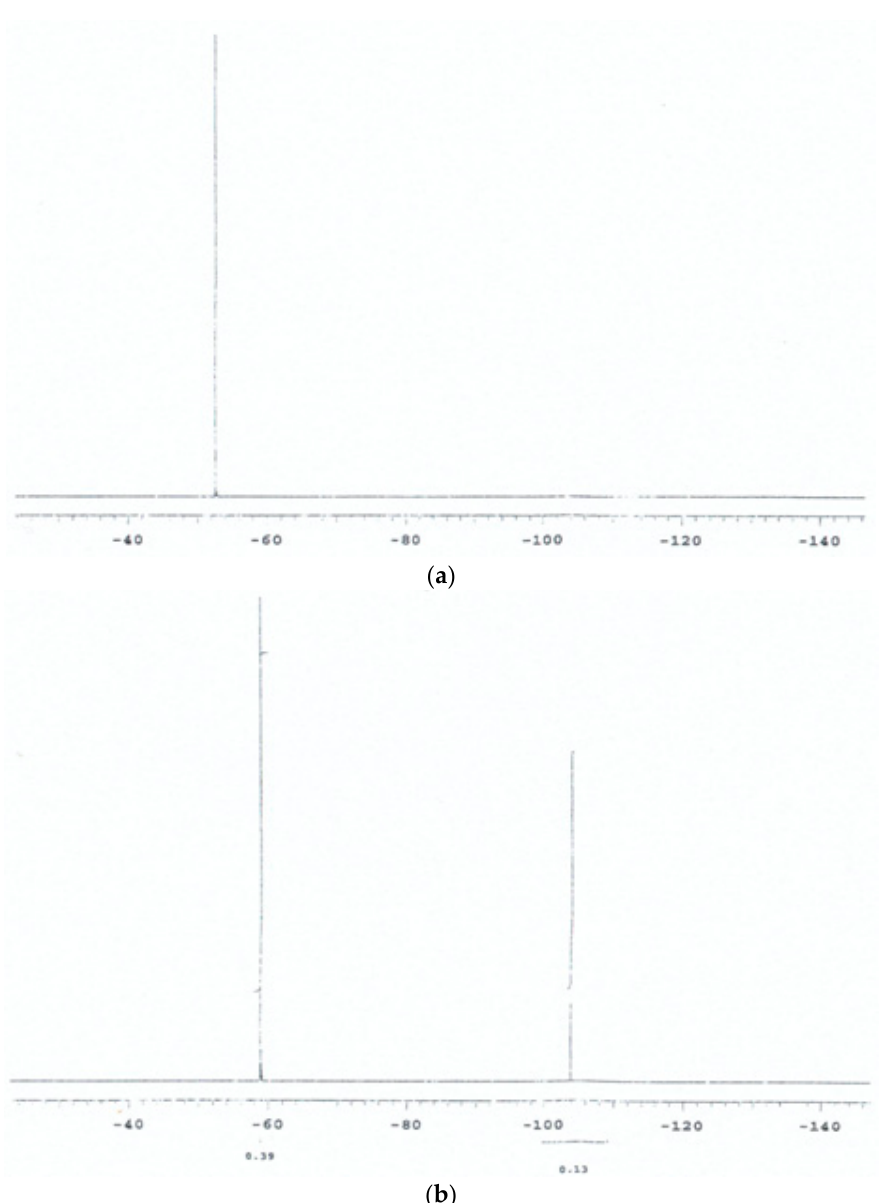
Figure 1. 19 F-NMR spectra of compounds ( a ) ( 4 ) and ( b ) ( 5 ) measured for solutions in dichloromethane at 25 °C. Chemical shifts ( δ ppm) of the fluoro residues are given relative to hexafluorobenzene, which is taken as 0 ppm. Note that all the shift values are negative.